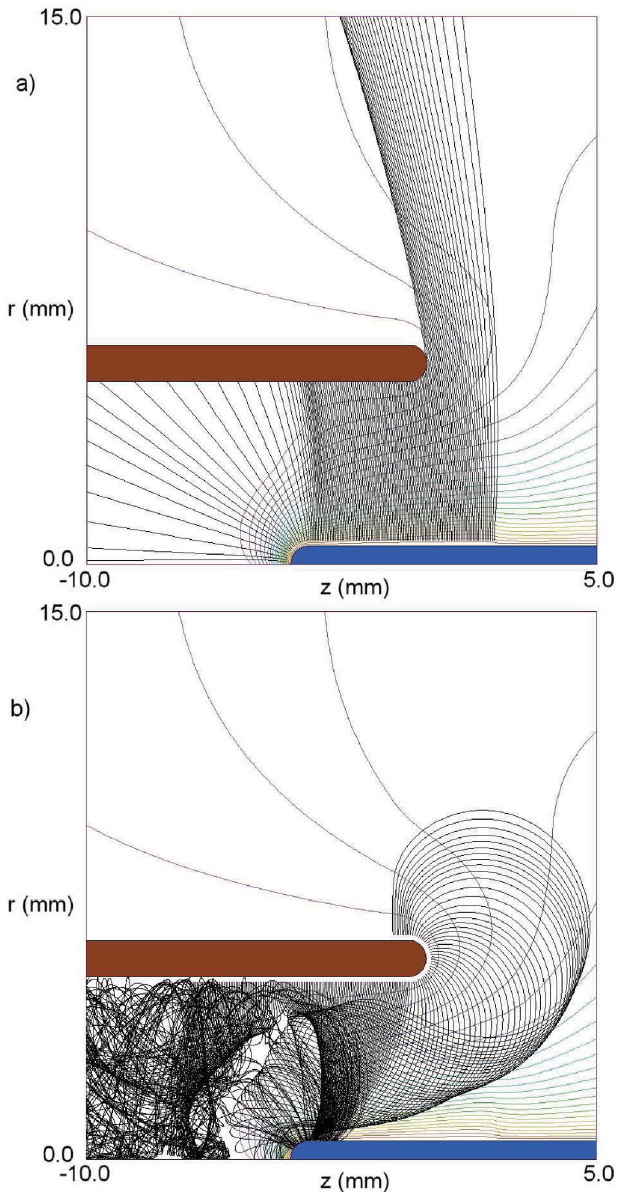
for the CRAD diode with R Ions. (b)